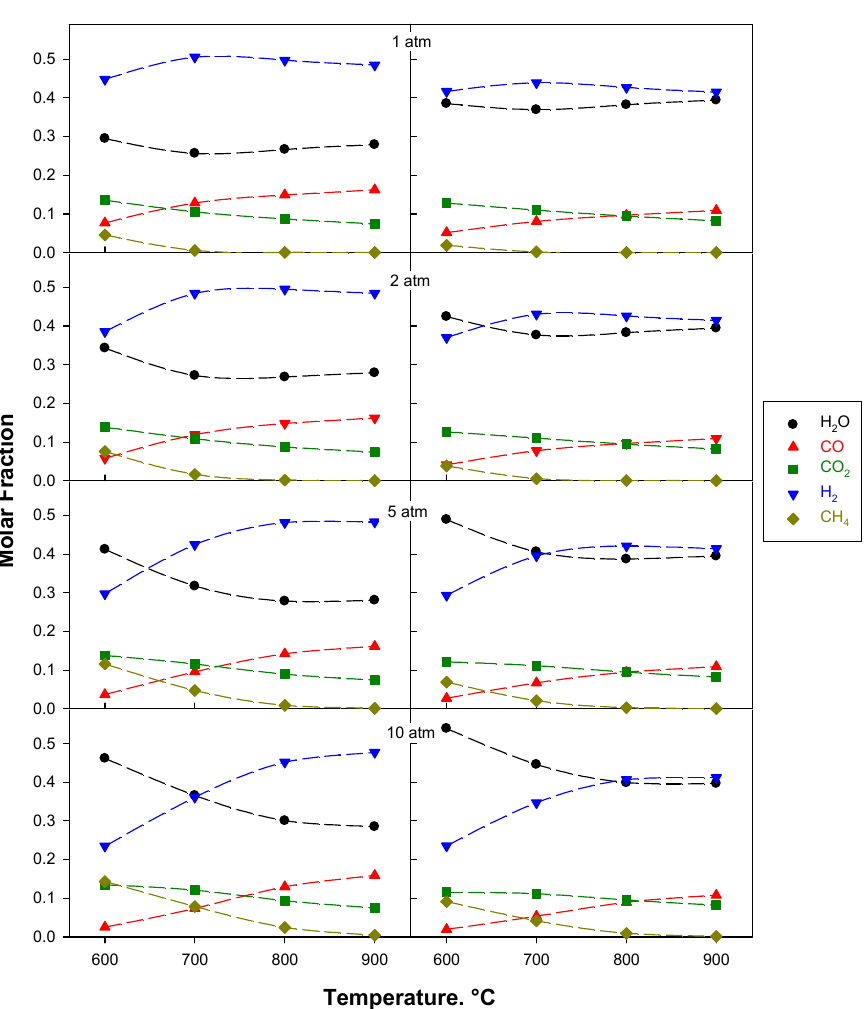
Figure 1. Equilibrium compositions as a function of temperature calculated at different pressures and H 2 O / C ratios. H 2 O / C = 2 on the left; H 2 O / C = 3 on the right. Fuel: Azeotropic stream (AZ).